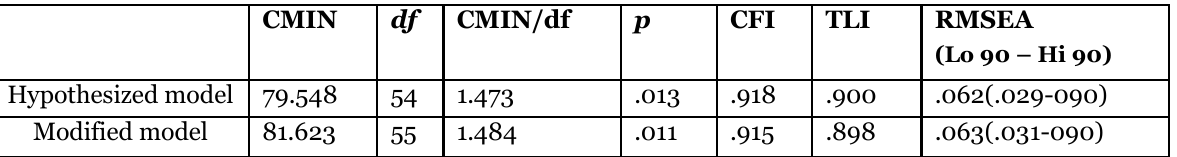
Fit Indices for the Measurement and Correction Model